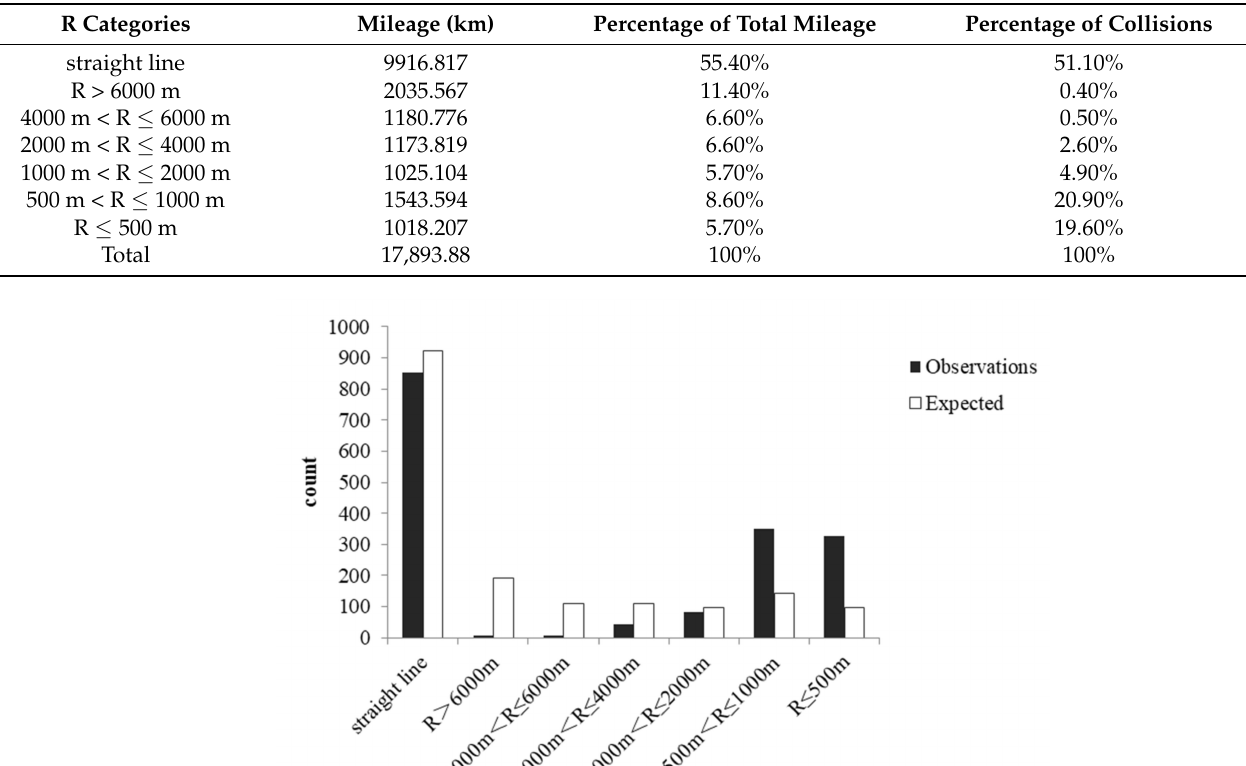
Table 6. Distribution of different curve radii in the total mileage and collisions.